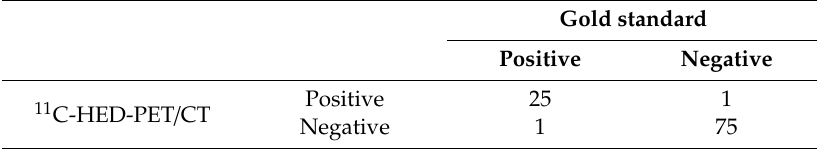
Table 1. 11 C-HED-PET / CT results in all 102 patients with correlation to findings at surgery, histopathology, biochemistry, clinical and radiological follow-up (combined gold standard).